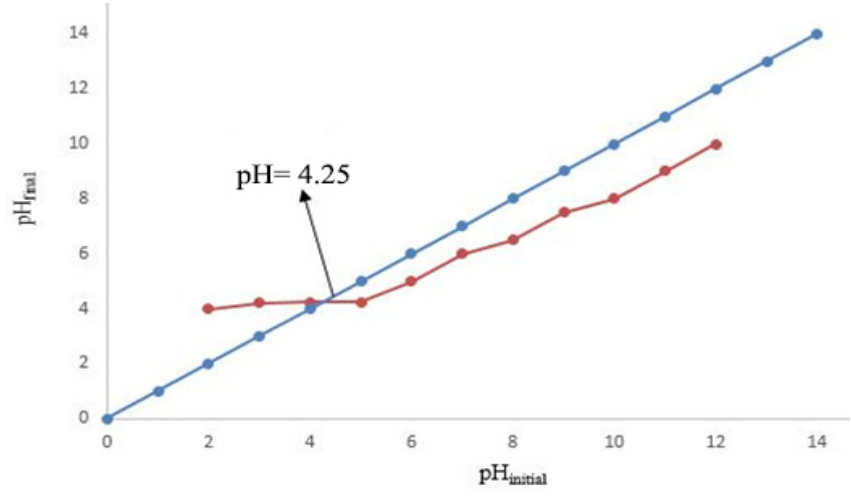
Fig. 10. pHpzc Determination of